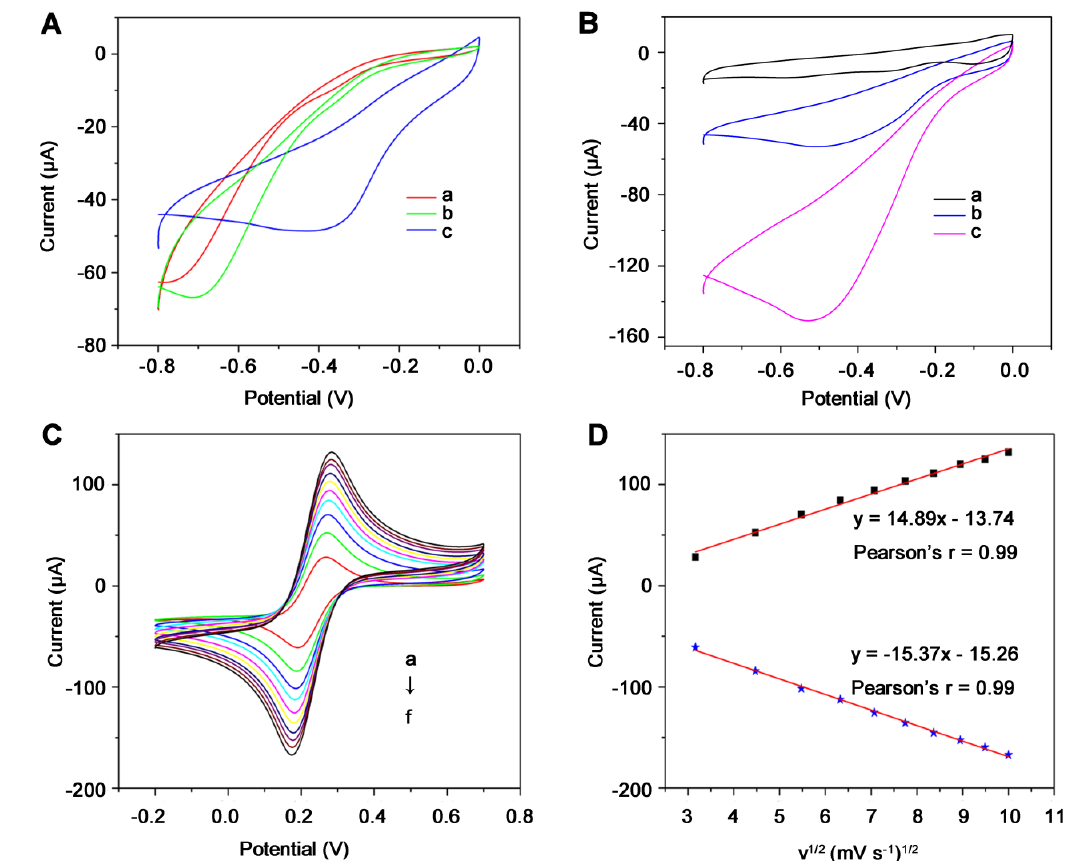
Figure 4. Electrocatalytic activities of the modified electrodes. ( A ) CV profiles of electrode modified by MoS 2 / GCE (a), MoS 2 -Au / GCE (b) and MoS 2 -Au-Ag / GCE (c) in 5 mM H 2 O 2 . ( B ) CV curves of MoS 2 -Au-Ag / GCE in PBS (a), 5 mM H 2 O 2 (b) and 10 mM H 2 O 2 (c). ( C ) Kinetic analysis of MoS 2 -Au-Ag / GCE at scan rates ranging from 10 to 100 mV s − 1 . ( D ) Linear fits of the oxidized peak current ( I pa ) and reduced peak current ( I pc ) versus the square root of the scan rate (v 1 / 2 ).